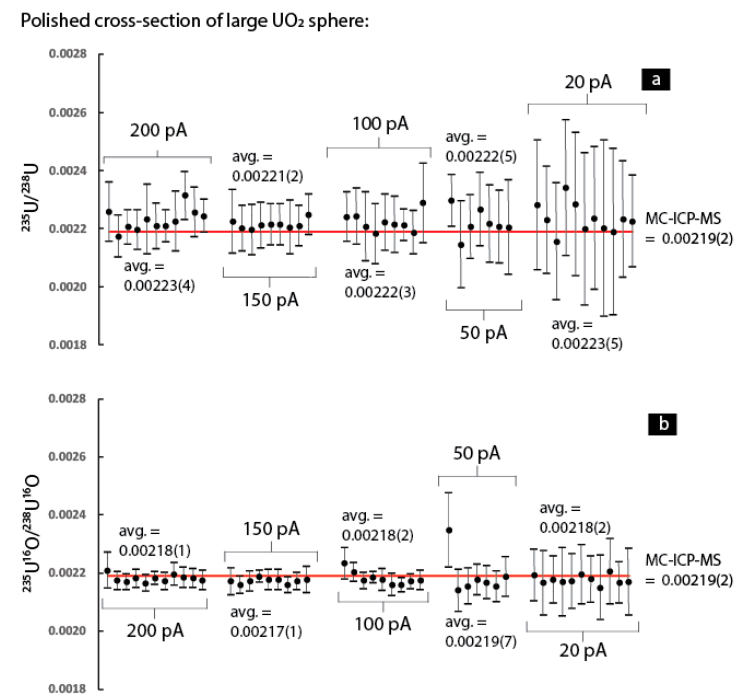
Figure 3. Plot of each analysis’s ( a ) 235 U / 238 U and ( b ) 235 U 16 O / 238 U 16 O ratio and its associated 1 σ uncertainty for the UO 2 sphere is shown relative to the solution MC-ICP-MS value (red line). Individual analyses are grouped according to the five primary beam currents (200 pA, 150 pA, 100 pA, 50 pA, and 20 pA) that were used to analyze the UO 2 sphere.